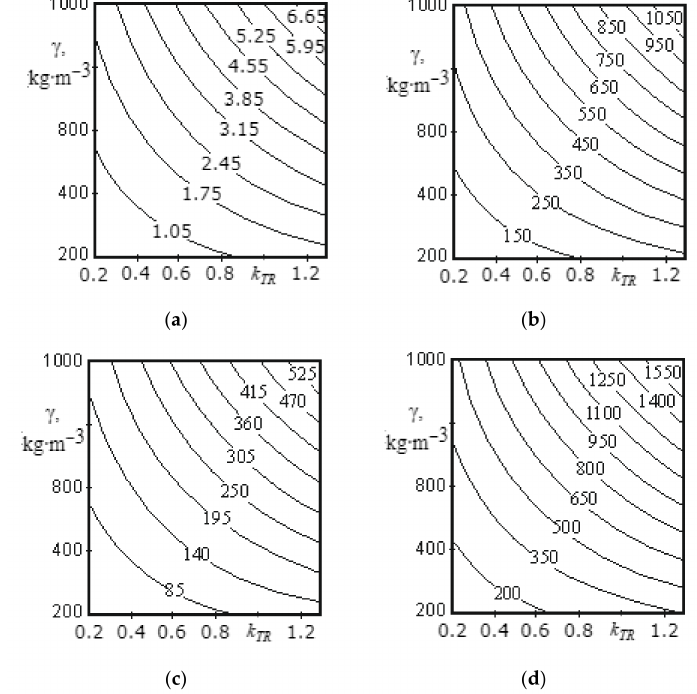
Figure 10. Dependence of the power value on the friction coefficient of the material against steel and on the material density for the middle screw: ( a ) the surface constructed based on calculations on the first component; ( b ) the surface constructed based on calculations on the second component; ( c ) the surface constructed based on calculations on the third component; ( d ) the surface representing the change in the total power value for all three